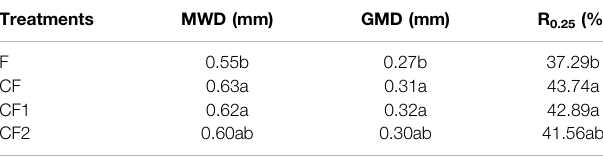
TABLE 4 | Effects of co-application of biochar and chemical fertilizers on soil aggregate stability.